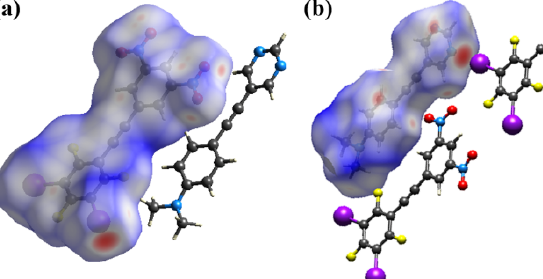
Figure 5. Hirschfeld surface showing d norm for 3 in ( a ) and for 1 in ( b ) highlighting the close contacts, in red, between adjacent molecules within the cocrystal 1 • 3 .